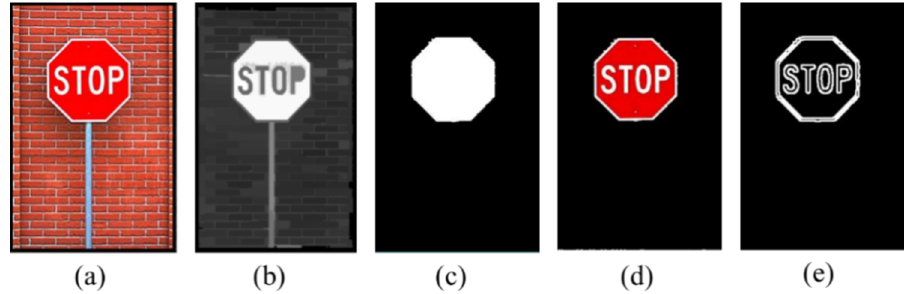
Figure 8. Example of using the masking method: ( a ) input image, ( b ) saliency map, ( c ) the proposed saliency cuts, ( d ) full-color space salient objects, ( e ) outer and inner edges.